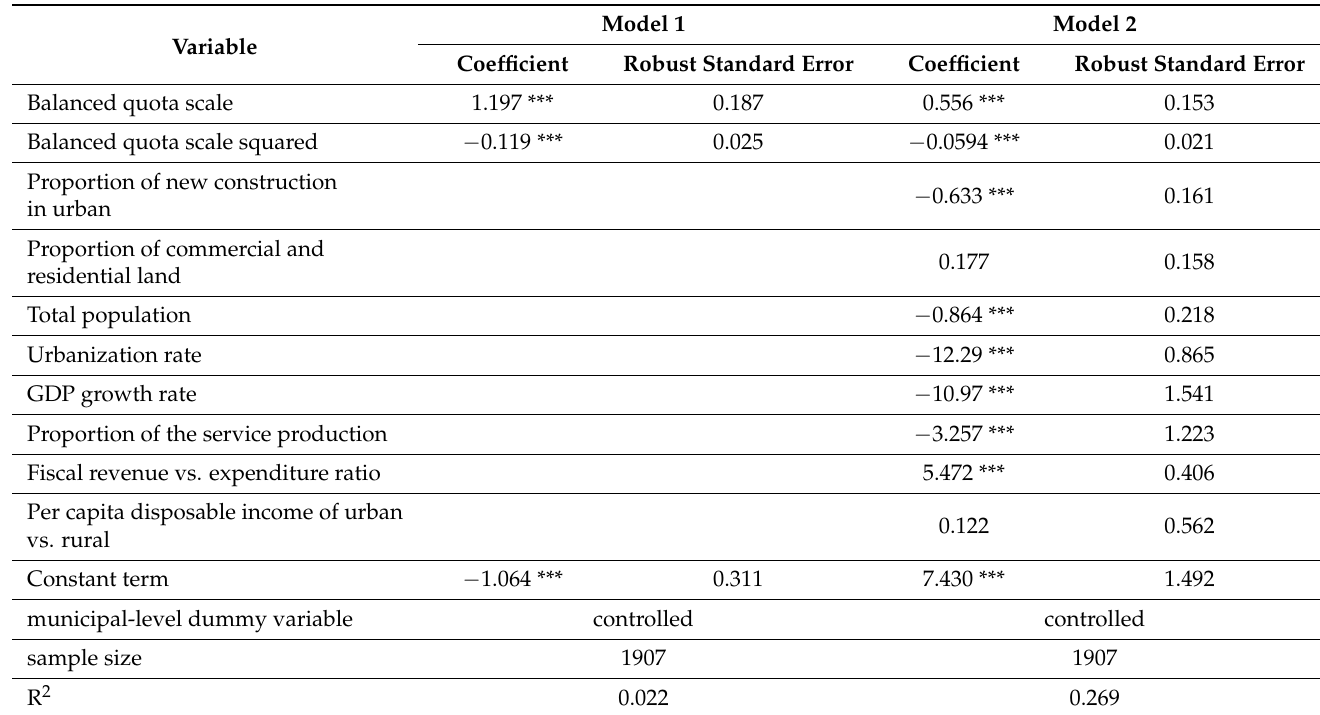
Table 3. Estimated results of the impact of the scale of project-based balanced quota on